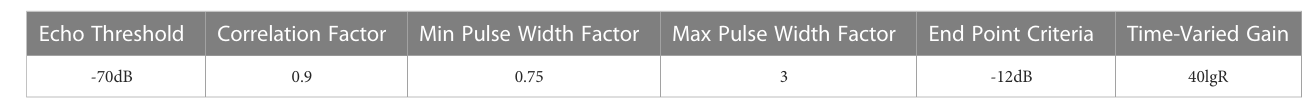
TABLE 1 Setting parameters for individual target analysis.